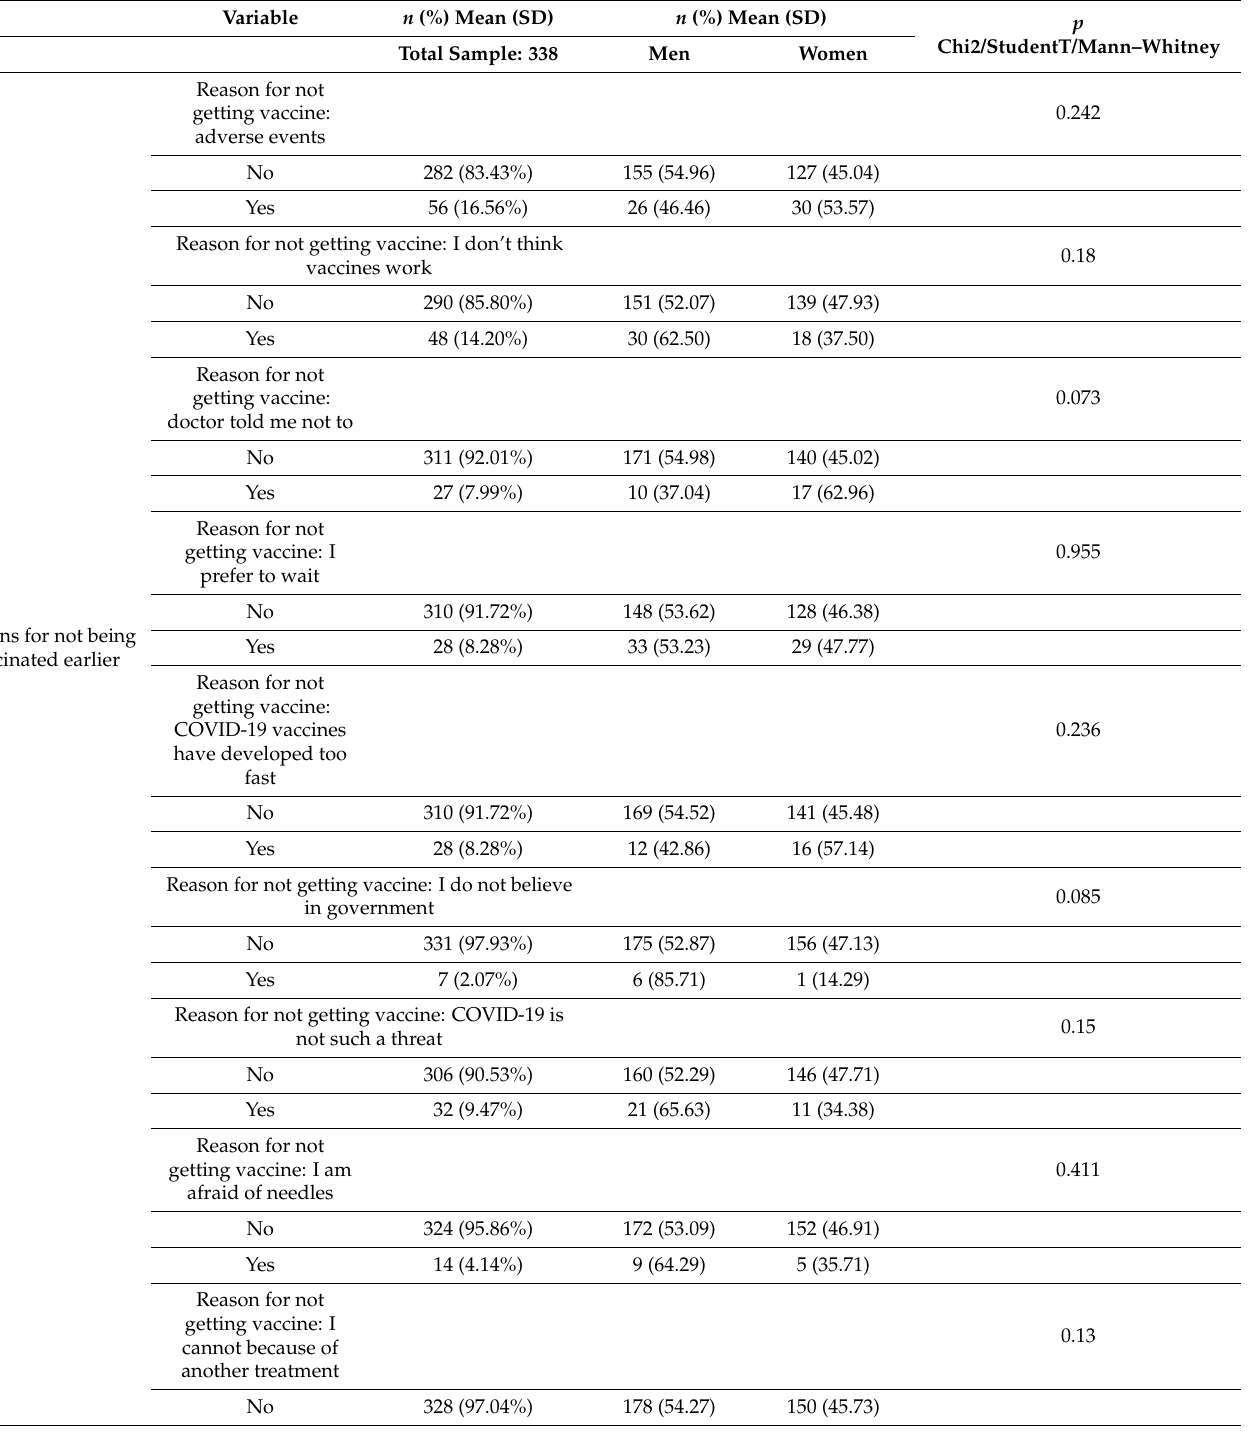
Table 1. Reason for not being vaccinated earlier (part 6 of the survey) and for getting the COVID-19 vaccine (part 7 of the